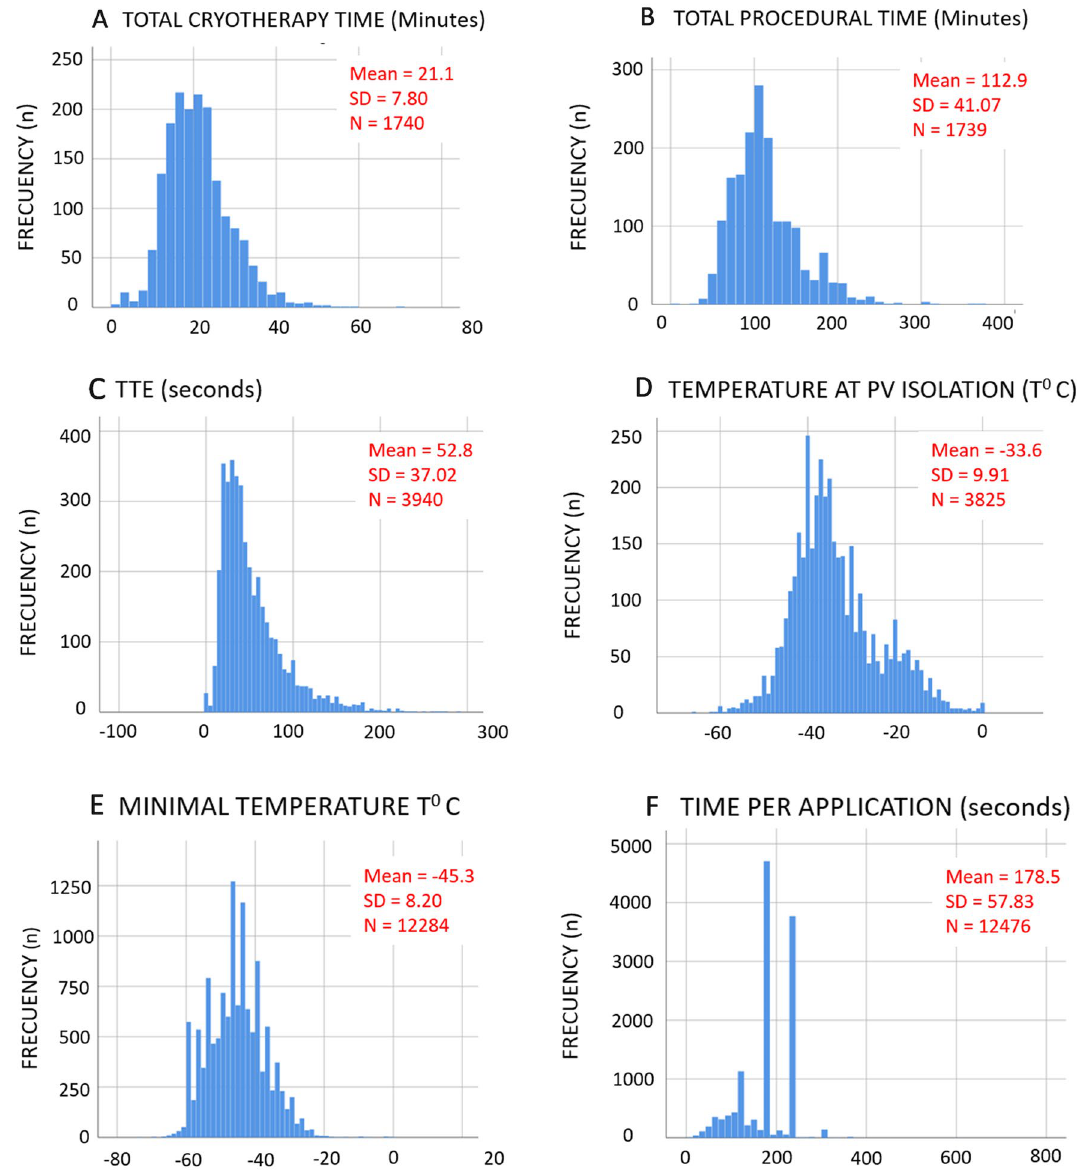
Figure 2. Histograms of the distribution of frequencies: total cryotherapy time ( A ), total procedural time ( B ), time-to-effect ( C ), temperature at PVI ( D ), minimal temperature during application ( E ), time per-application ( F ). SD standard